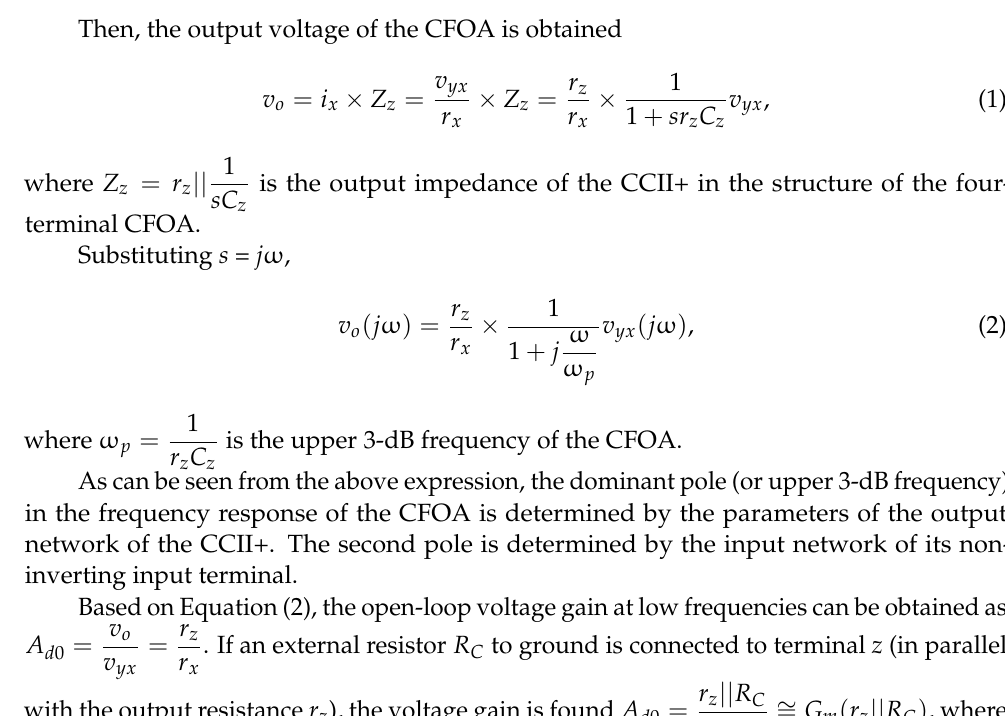
Figure 1. Current-feedback operational amplifier (CFOA) and externally available z terminal (or four-terminal CFOA): ( a ) symbol representation; ( b ) equivalent